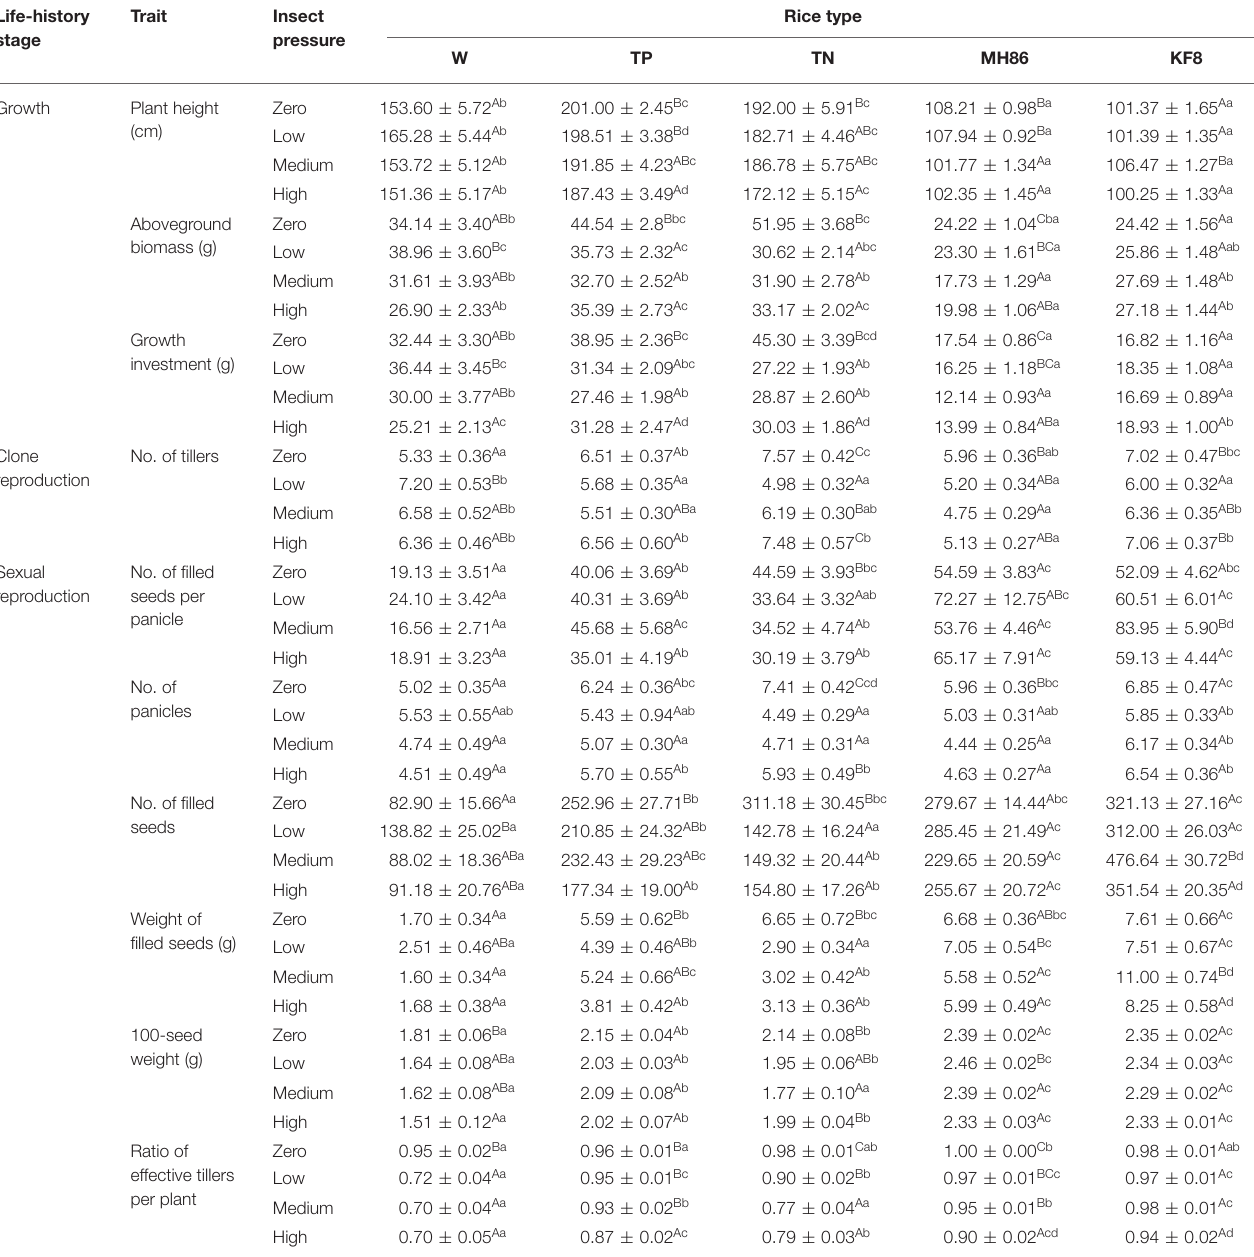
Different letters following the average values in the same rows indicate significant differences in levels of fitness-relative traits under four insect pressures according to Duncan’s multiple rangetest.Thecapitallettersrepresentthecomparisonofthesamepopulationamongfourinsectpressures,andthelower-caselettersrepresentthecomparisonamongfivepopulations under the same insect